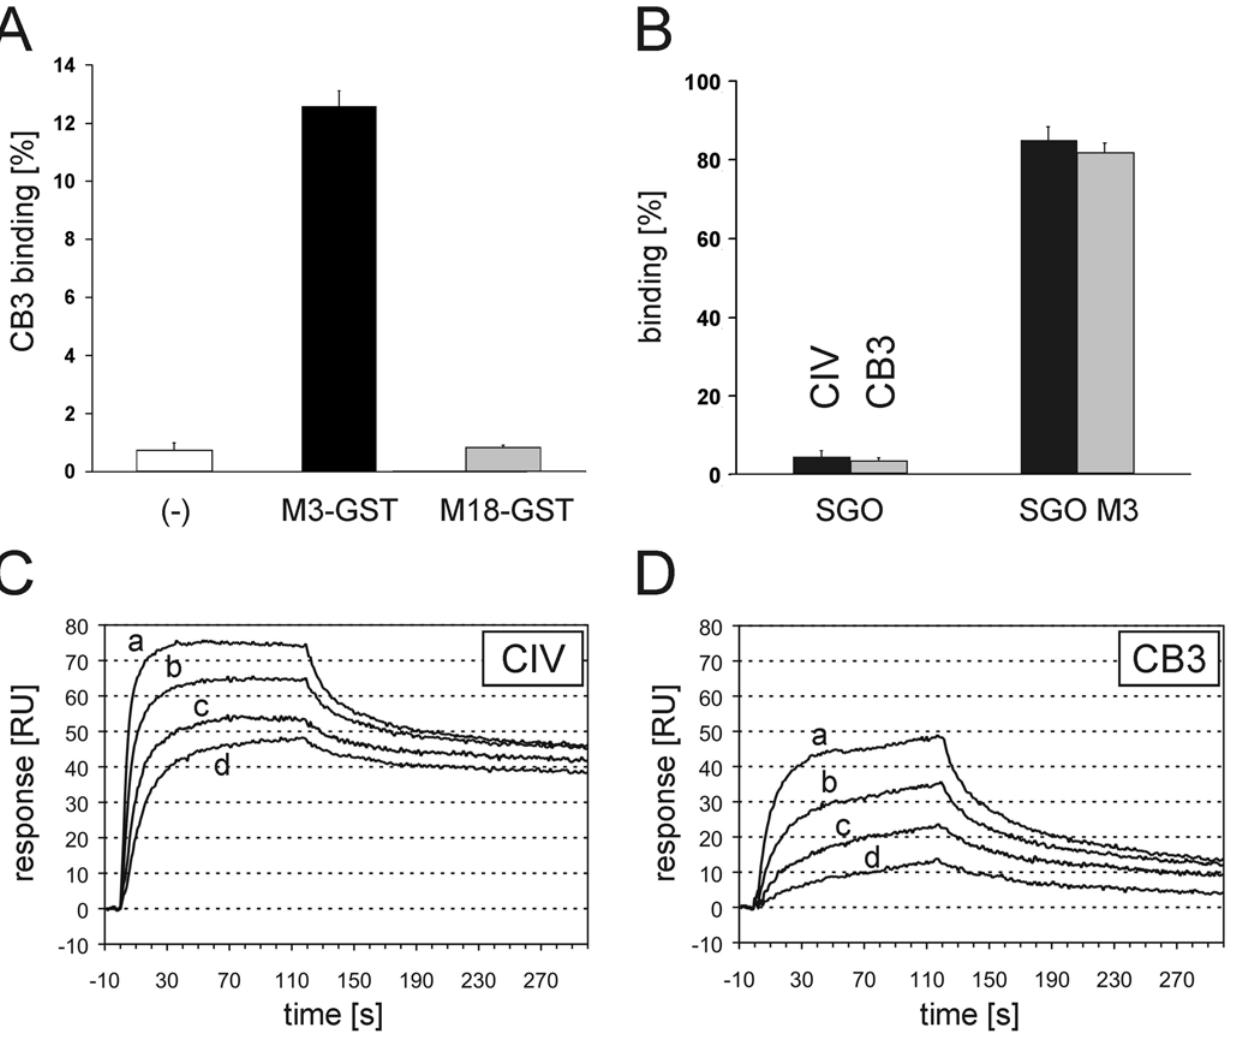
Figure 2. CB3 binding by M3-protein. ( A ) Interaction with 125 I-CB3 was measured in a pull-down assay with, M3-GST ( black bar ), or M18-GST ( grey bar ) protein coupled to glutathion sepharose beads. A control sample with glutathion separose alone ( 2 ) was included ( white bar ). ( B ) Binding of 125 I- CIV (black bars) or 125 I-CB3 ( grey bars ) to S. gordonii that heterologously expressed M3 protein on its surface ( SGO M3 ) and that of the wild type control ( SGO ) was expressed as a percentage of total radioactivity input. Error bars in A and B represent the standard deviation of the triplicate measurements. ( C and D ) Surface plasmon resonance measurements of the interaction between M3-protein and immobilized CIV ( C ) or CB3 ( D ), respectively. Injection of M3-protein at different concentrations (a: 50 m g/ml, b: 25 m g/ml, c: 12.5 m g/ml, d: 6.25 m g/ml) started at t=0 s and stopped at t=120 s. The response is expressed in response units (RU).